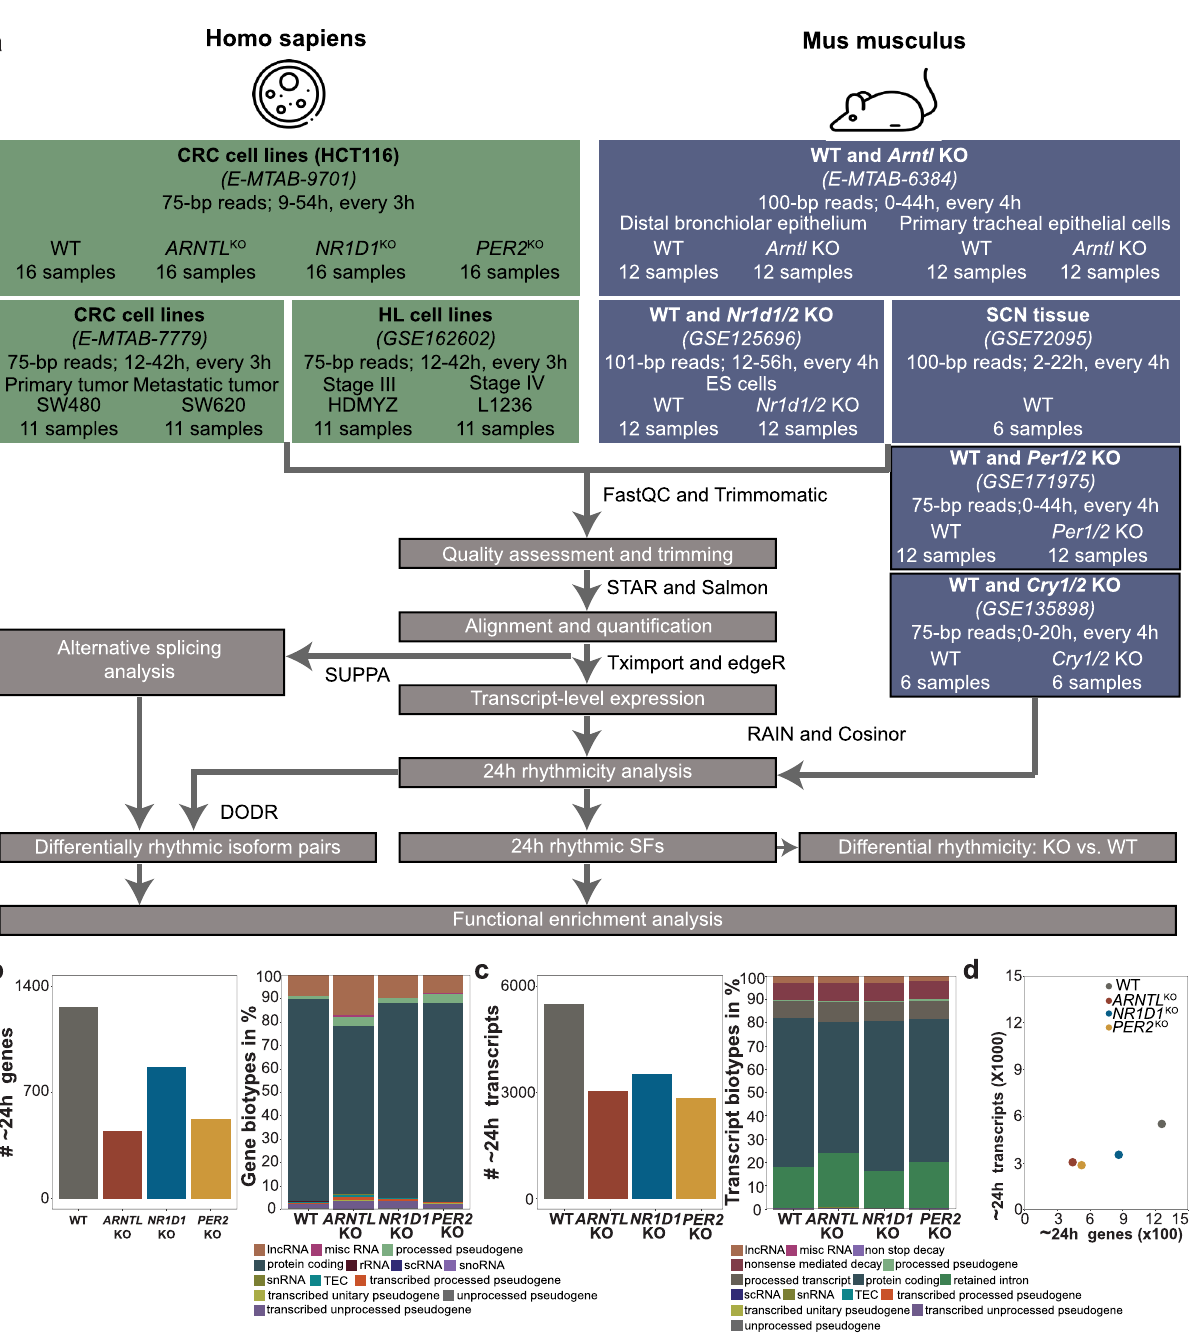
Fig. 1 RNA-seq data analysis showed differences in the circadian phenotype between gene- and transcript expression values. a Schematic representation of the pipeline for RNA-seq data analysis. The input data consisted of 222 samples from eight mammalian time- course RNA-seq data. Murine datasets from Per1/2 KO (GSE171975) and Cry1/2 KO (GSE135898) were only analysed at the gene level. b – d Classi fi cation of 24 h rhythmic features in HCT116 datasets at ( b ) gene level and ( c ) transcript level showed a decline in the total number of circadian expressed genes/transcript-sets and changes in their biotypes due to core-clock disruption. d Scatter plot represents each of the HCT116 WT and KO cells according to the total number of 24 h rhythmic genes ( x -axis) and the total number of 24 h rhythmic transcripts ( y -